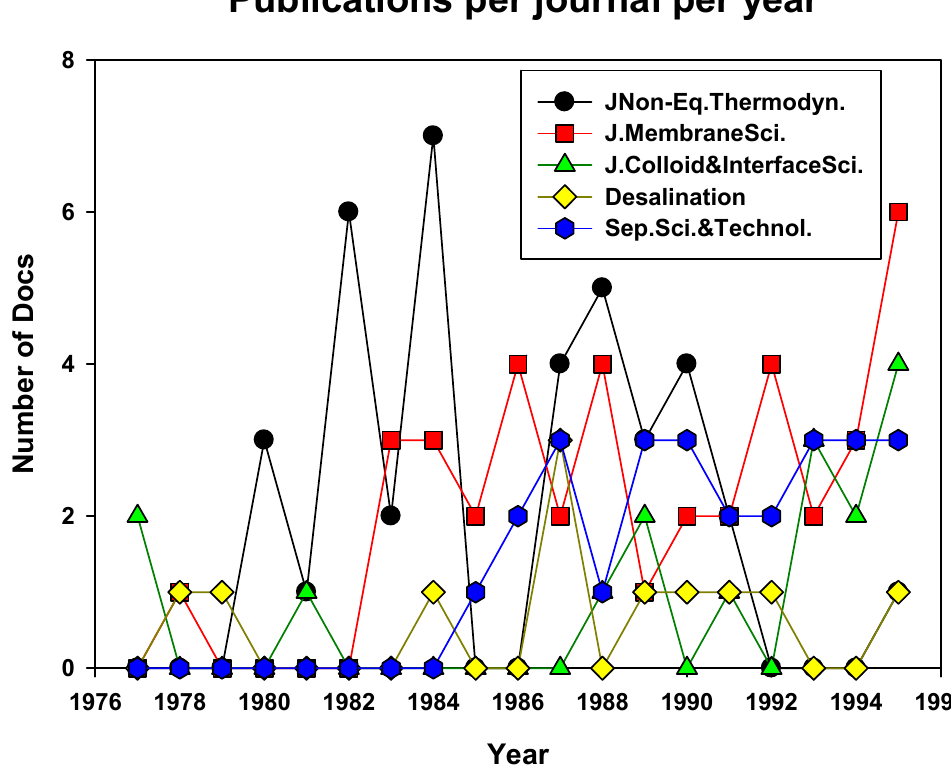
Figure 2. Spanish based membrane ‐ related publications in selected international journals from 1970 to 1995.